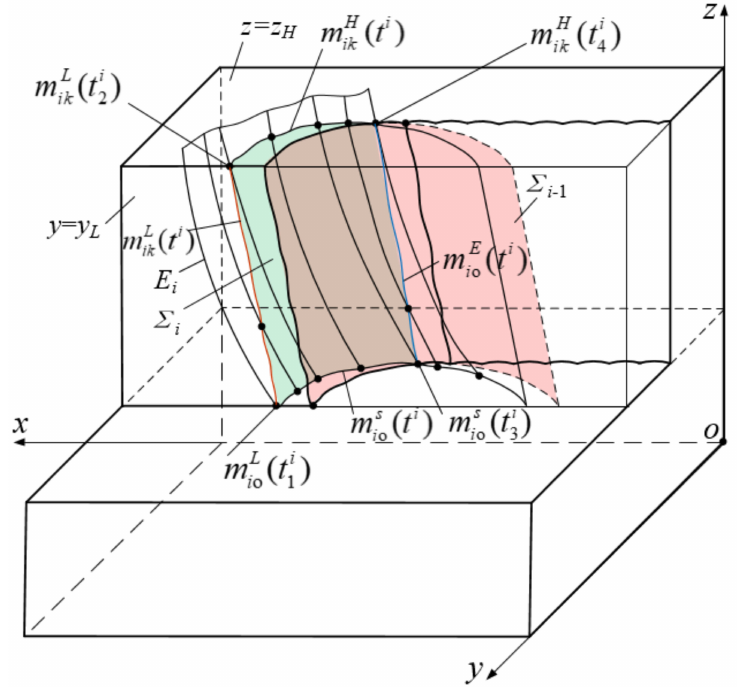
Figure 3. Instantaneous engagement between the cutting edge and the